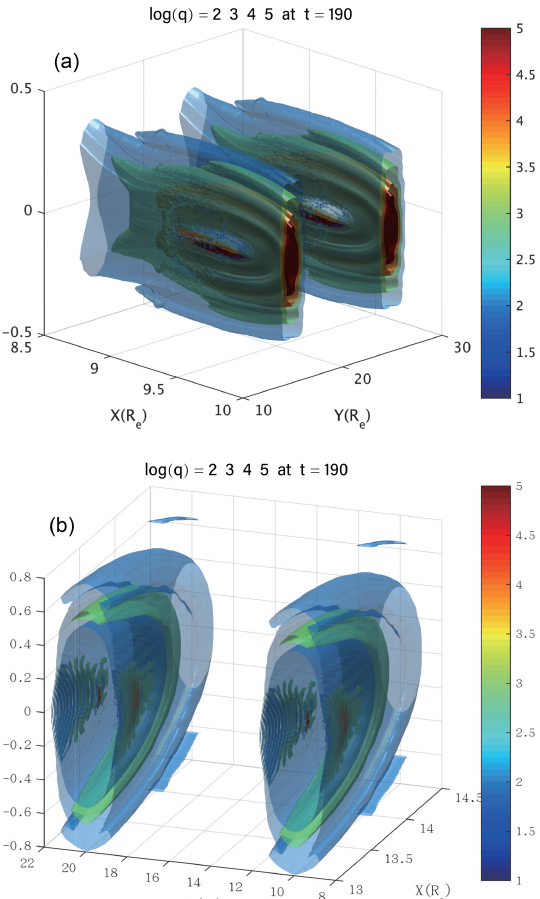
Figure 8. (a) Iso-surface of the logarithm of squashing degree in the broader 3-D domains, which include five periods of repeating QSL distribution at t = 190; (b) same as the upper panel, except that only the iso-surface of the logarithm of squashing degree equaling 3 is